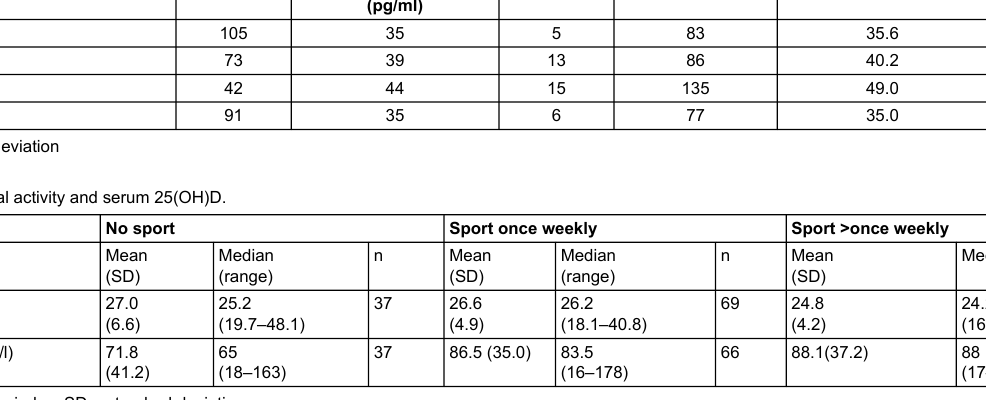
Table 4: 1,25(OH)2D level according to season. Season of the year